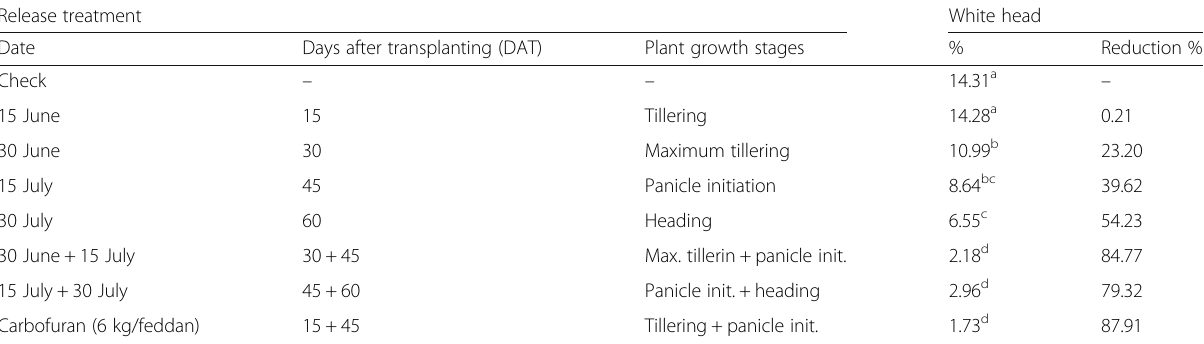
Table 1 Schedule of Trichogramma evanescens release (30,000 wasps/feddan) for control of the rice stem borer, Chilo agamemnon , in rice fields, 2015 season Release treatment